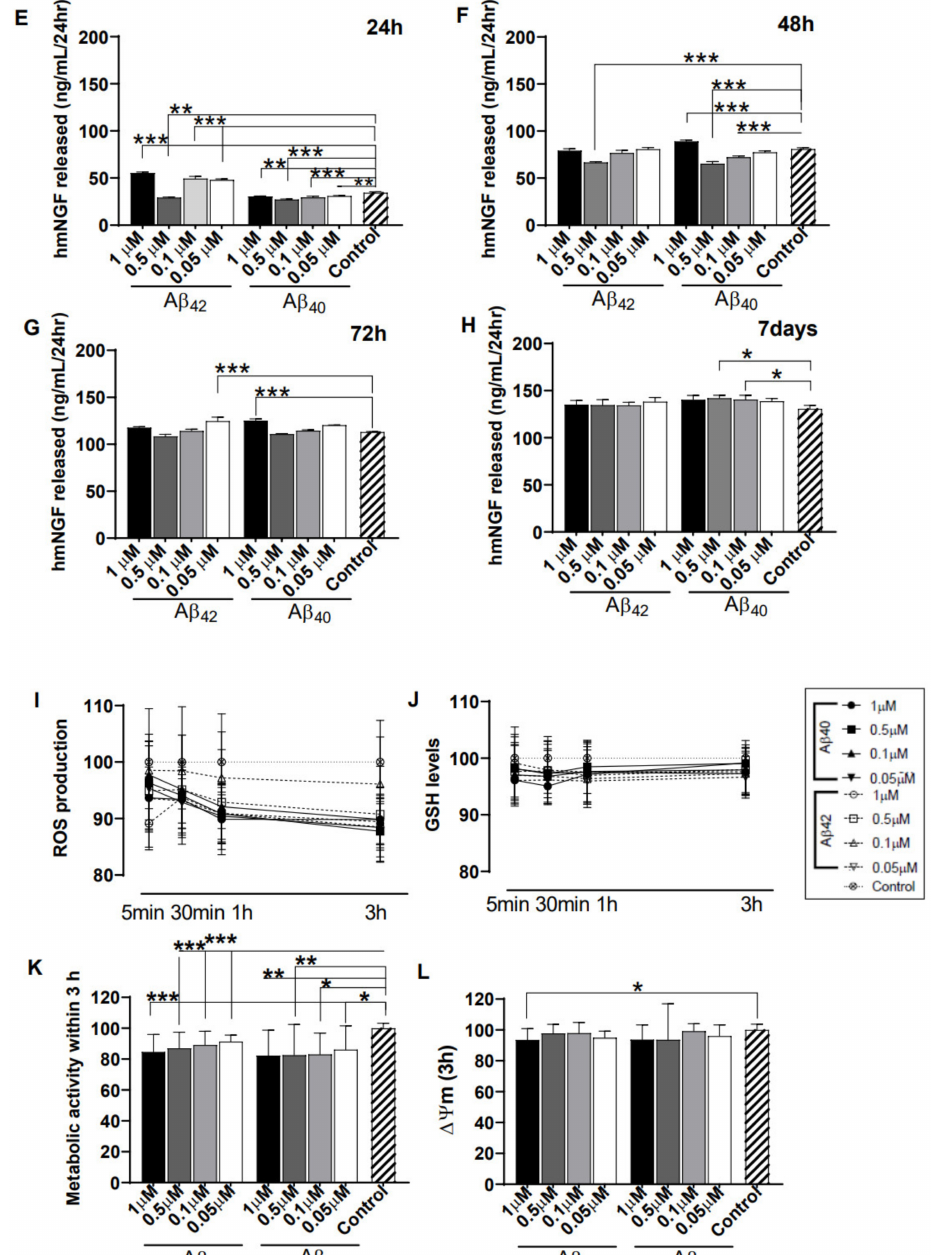
Figure 2. Impact of A β peptides on cell death, hmNGF release, and stress pathways: NGC0211 cells (7 × 10 4 cells/well for 24/48/72 h or 3 × 10 4 cells/well for 7 days) were seeded on 24-well plates and incubated with different A β 40/42 concentrations (1, 0.5, 0.1, 0.05 µ M) for different time points (24, 48, 72 h, and 7 days) ( A – H ). Supernatant was collected for measurement of hmNGF by ELISA and the cells were further trypsinized and stained with Annexin-V/propidium Iodide (PI) dyes. ( A – D ) Cells stained with Annexin-V/PI dyes were acquired in a flow cytometer and data is represented as the stained percent population as follows: early apoptotic cell death (Annexin V + ), and dead/necrotic cells (Annexin PI +